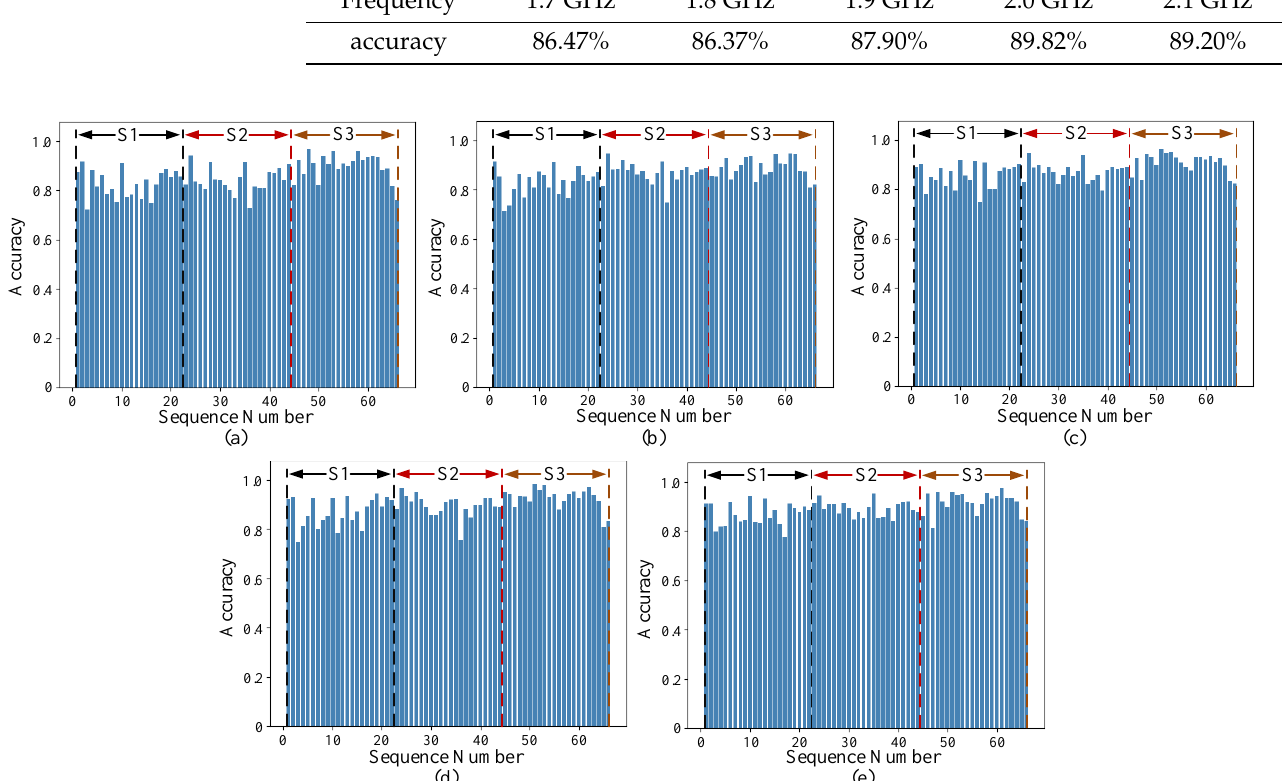
Figure 17. Recognition accuracy of the Bi-LSTM sub-network on five frequencies, namely ( a ) 1.7 GHz, ( b ) 1.8 GHz, ( c ) 1.9 GHz, ( d ) 2.0 GHz, ( e ) 2.1